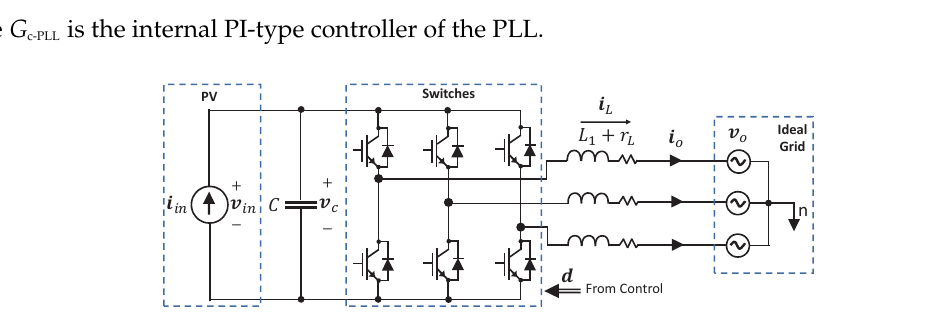
Figure 2. Three-phase inverter connected to ideal grid.